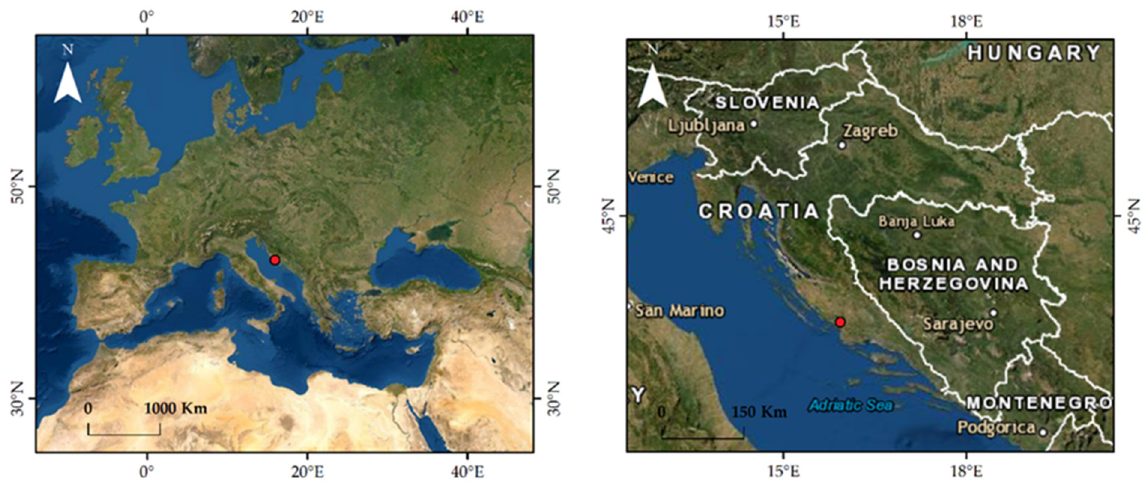
Figure 1. Study area (red dot show experimental location).